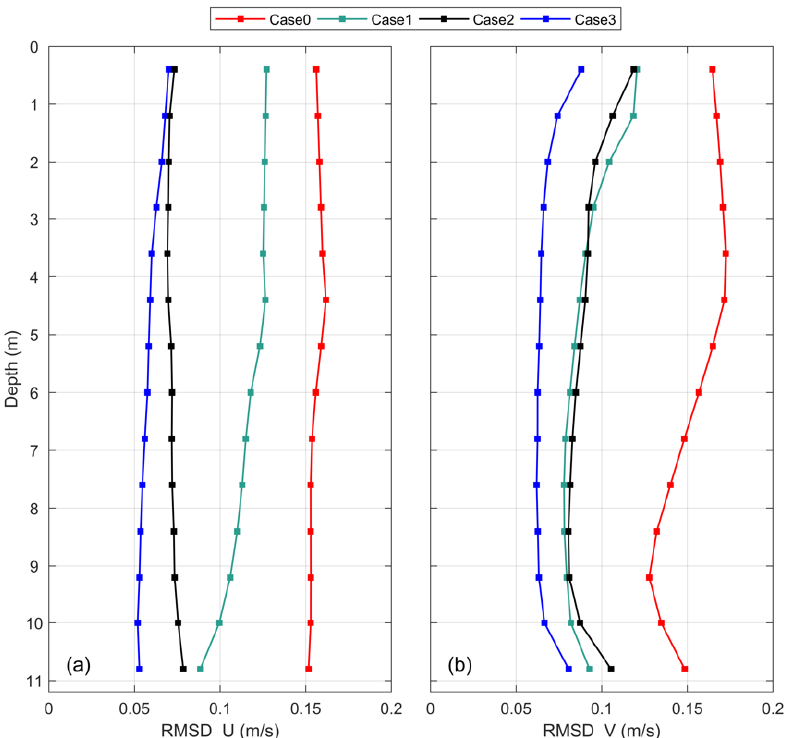
Figure 7. Root mean square differences (RMSDs) between model and ADCP data in vertical layers for ( a ) eastward and ( b ) northward velocities. for ( a ) eastward and ( b ) northward